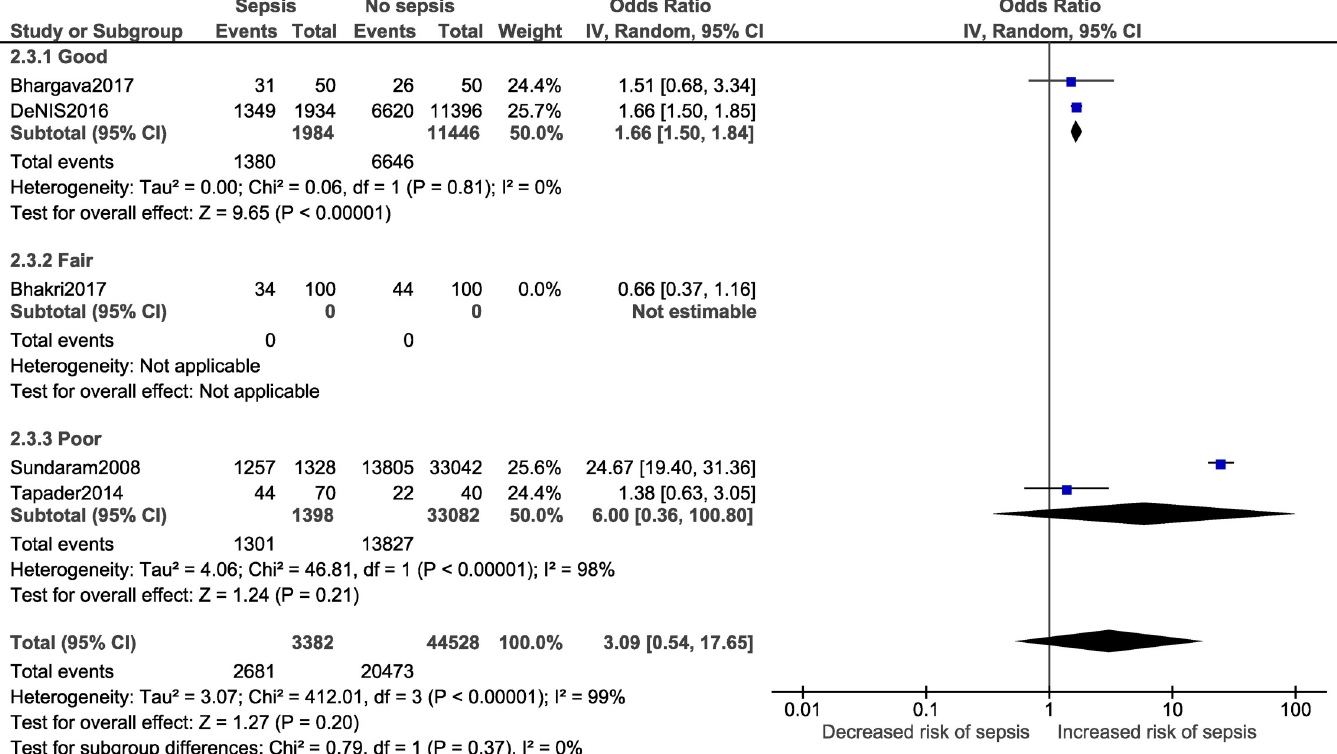
PLOS ONE | https://doi.org/10.1371/journal.pone.0215683 April 25,